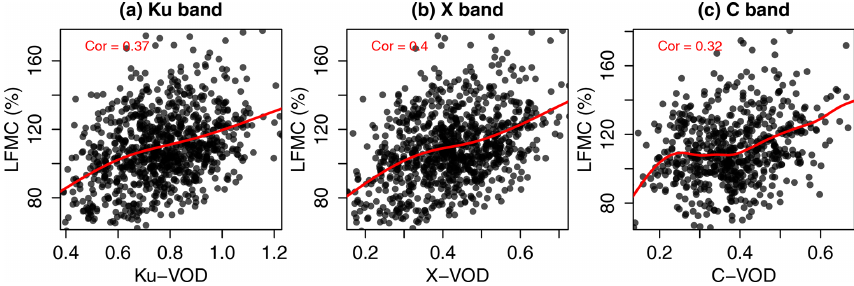
Figure 2. Global scatterplots and correlation of LFMC from the Globe-LFMC database against Ku-, X-, and C-VOD. The red lines are smoothing spline fits between the values at the x and y